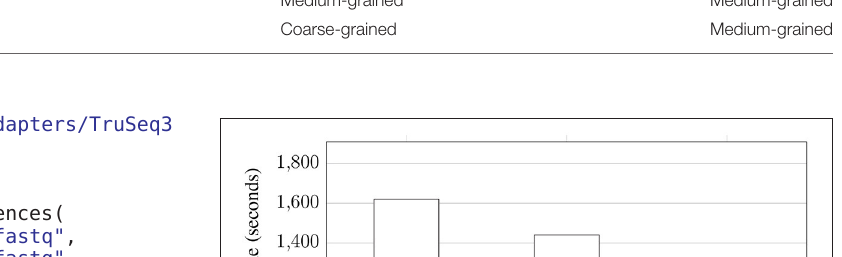
Table 1 | Granularity levels of parallel computations used for particular storage formats in particular phases of the EPS process. FASTA FASTQ Row-O Extract Coarse- or Medium-grained Coarse- or Medium-grained Process